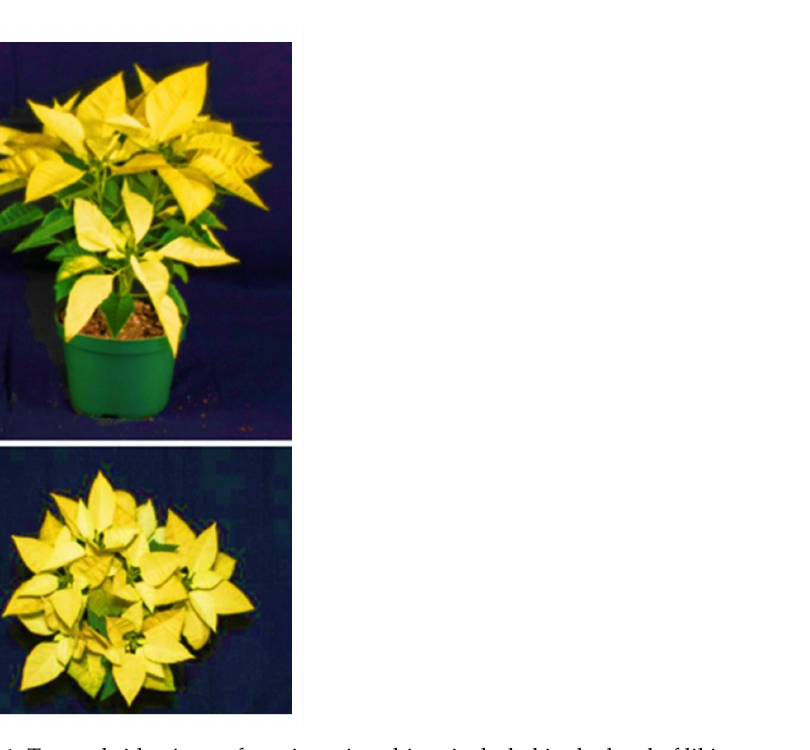
Figure 1. Top and side views of a poinsettia cultivar included in the level of liking survey. Select your level of liking based on each poinsettia variety on a scale from 1–7.